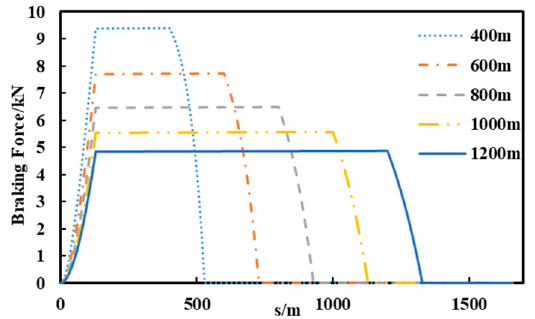
Figure 9. The braking force of one-side LLSM at different lengths of fault stator segment.